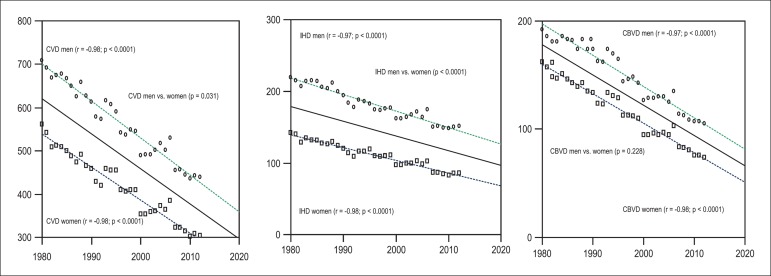
Analysis of the simple linear regression and comparison between the lines
of regression of mortality from cardiovascular diseases (CVD), ischemic
heart diseases (IHD), and cerebrovascular diseases (CBVD) between men
and women, in the period of 1980 to 2012.